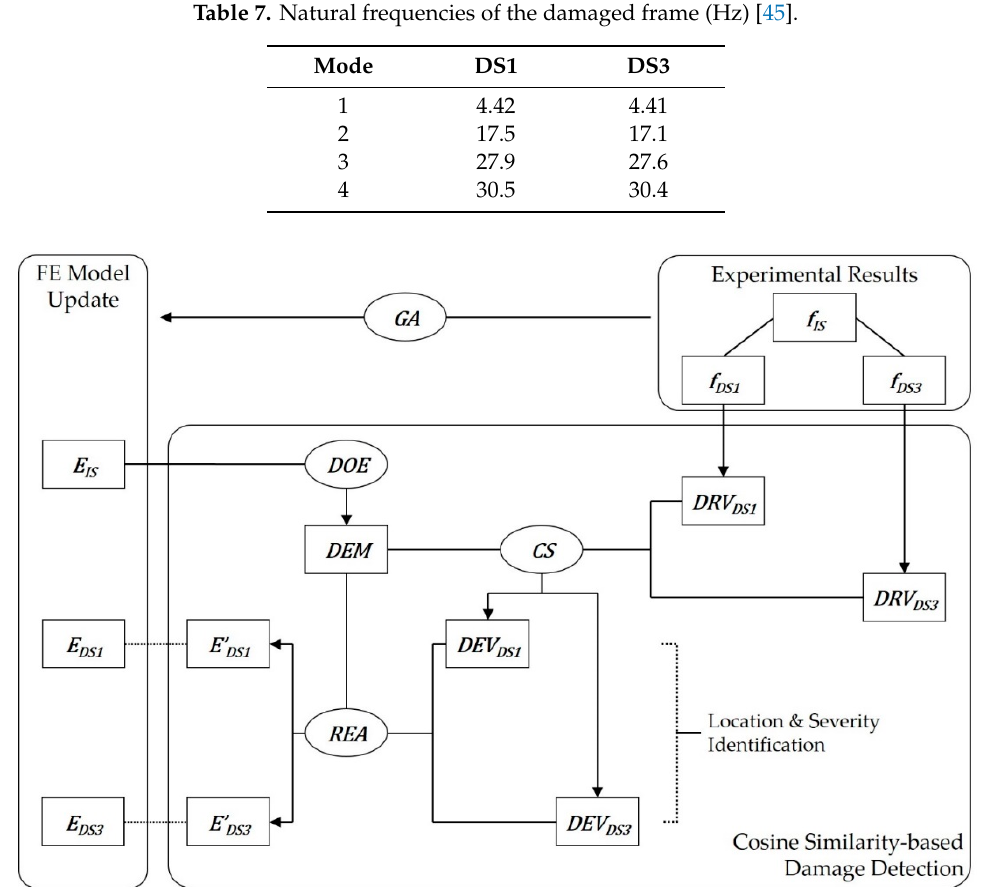
Figure 7. Flowchart of experimental verification for the portal frame model.